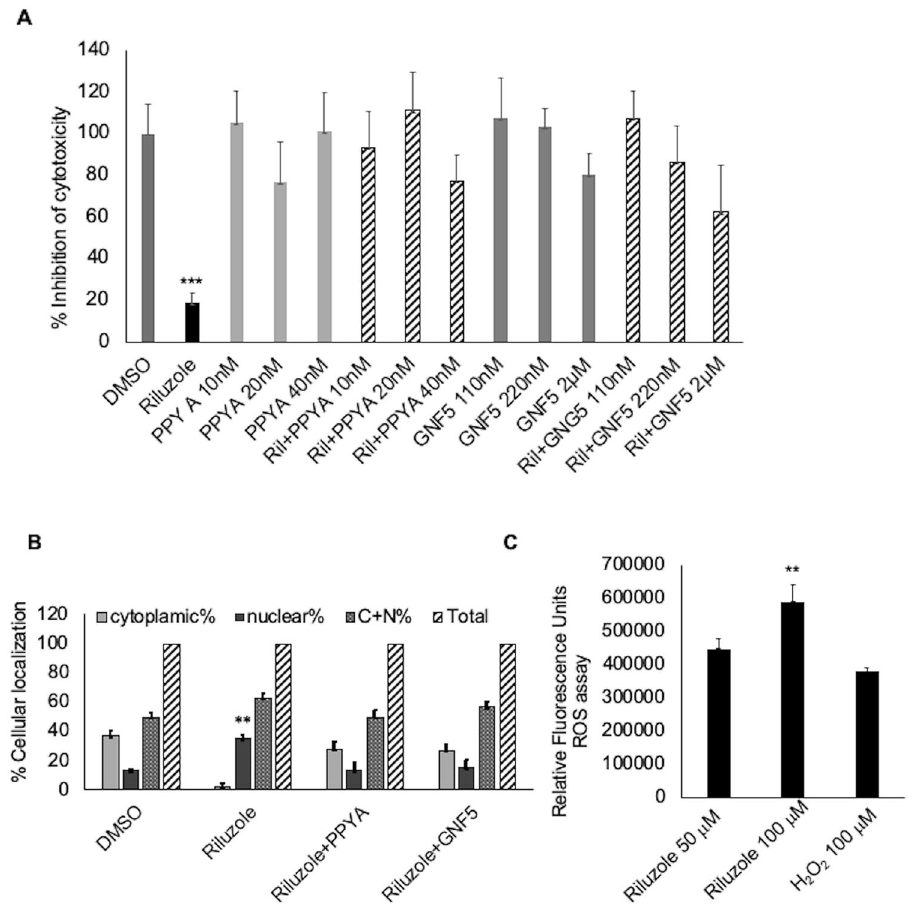
Figure 3. ( A ) Inhibitors of c-Abl Kinase block Riluzole-induced apoptosis. ( A ) Cytotoxicity was measured using MTT assay in LM7 cells in the presence of 100 μM Riluzole, or PPY A or GNF-5 or Riluzole + PPY A or Riluzole + GNF-5, p value < 0.0001***. ( B ) Subcellular localization of YAP in the presence of Riluzole (100 μM) or Riluzole + PPY A (20 nM) or Riluzole + GNF-5 (220 nM), p value < 0.05**. ( C ) Intracellular ROS was measured in LM7 cells treated with Riluzole or H 2 O 2 as a positive control. These experiments were repeated three times with triplicate samples, p value < 0.05**.